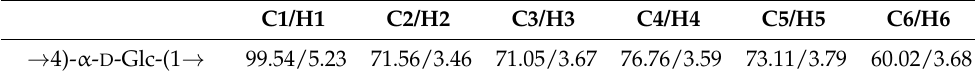
Table 2. 1 H and 13 C NMR chemical shifts of polysaccharide